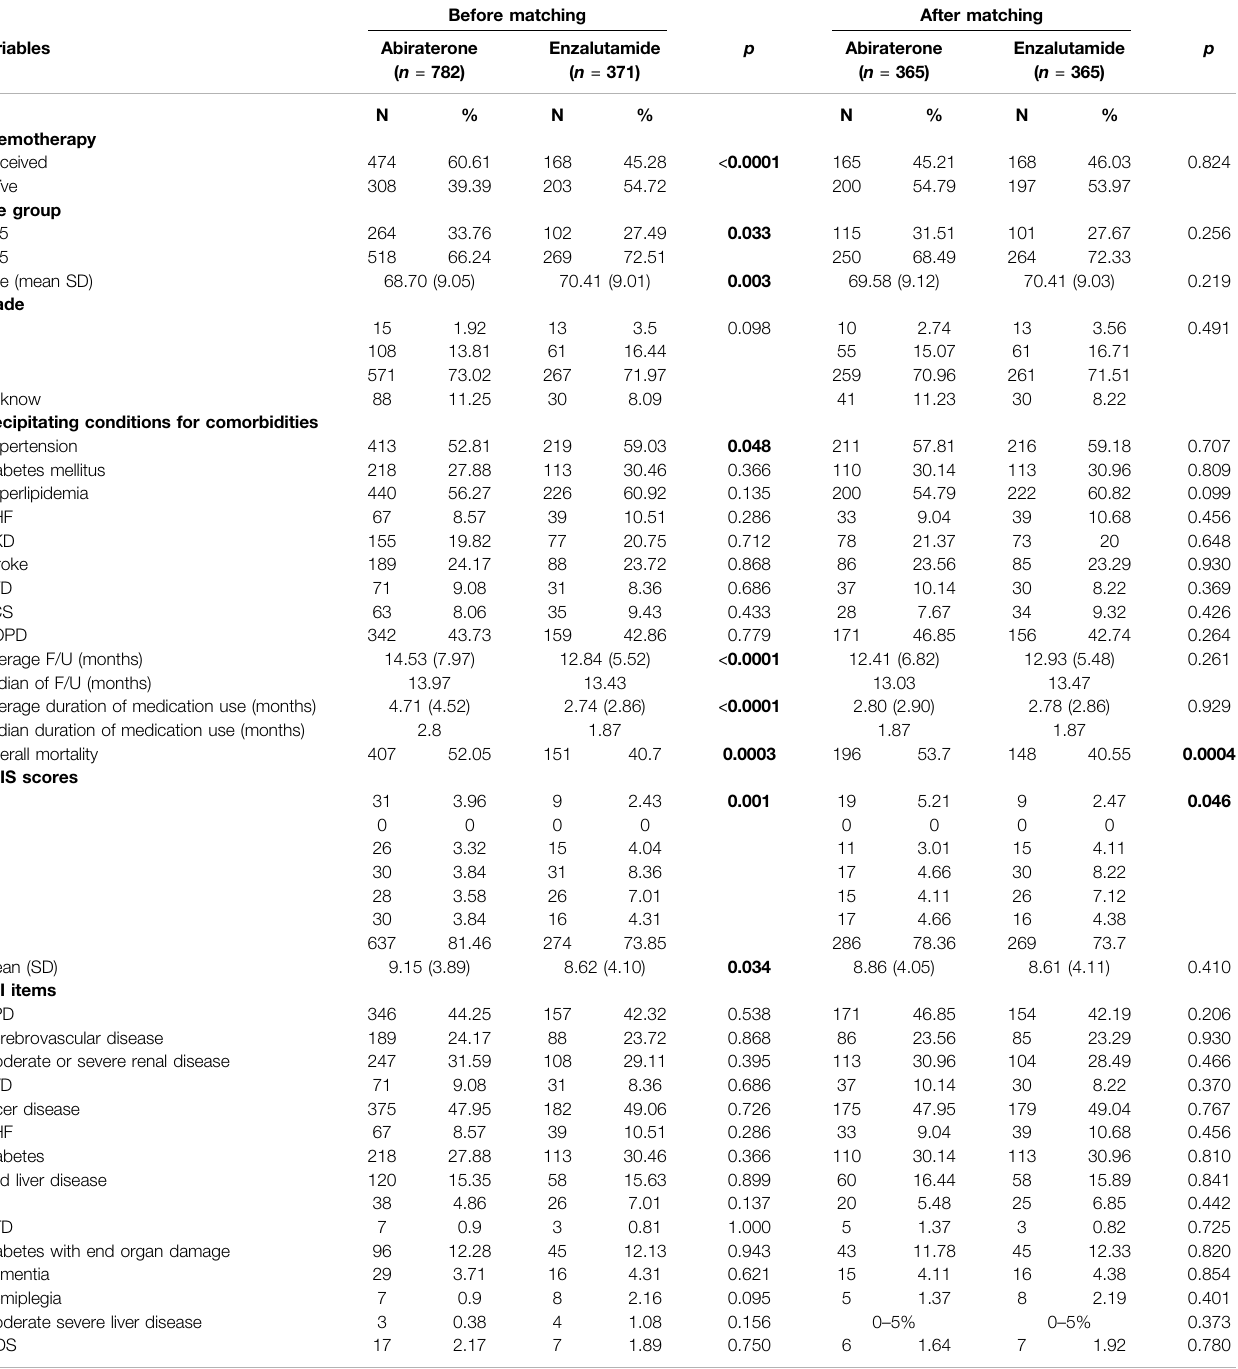
TABLE 1 | Demographic and clinical characteristics of